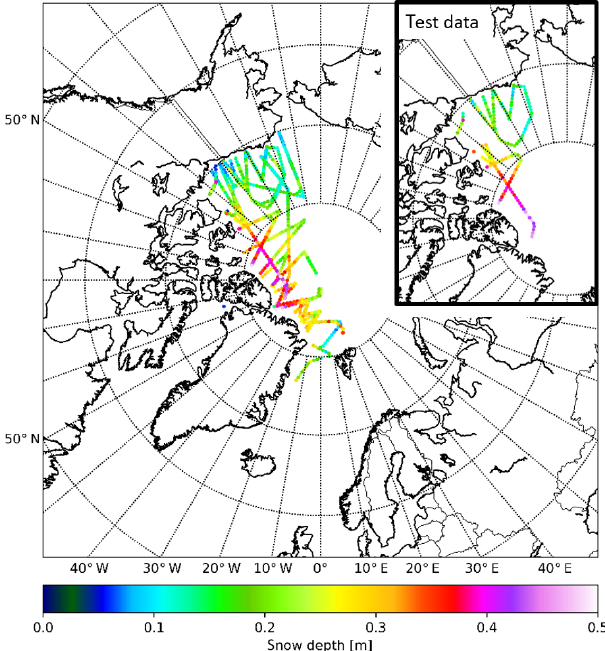
Figure 3. Flight tracks of the Operation Ice Bridge (OIB) cam- paigns 2013, 2014 and 2015. The measured snow depth is colour- coded. The box on the top right shows which part of the OIB data are used as test